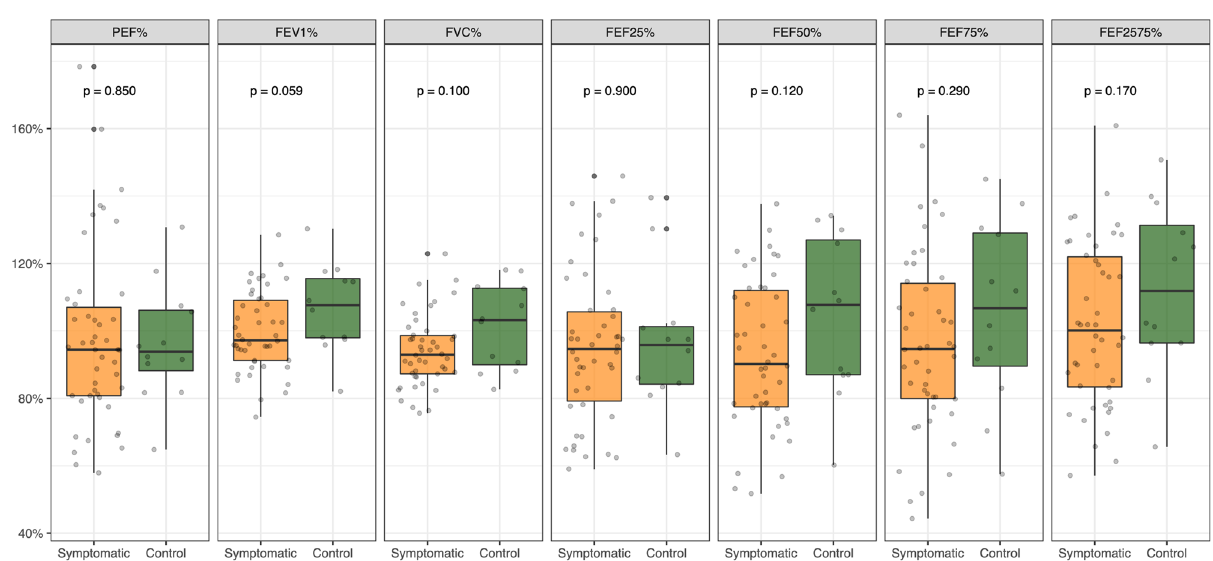
Figure 2. Spirometric patterns in the AR symptomatic subjects (orange) and control group